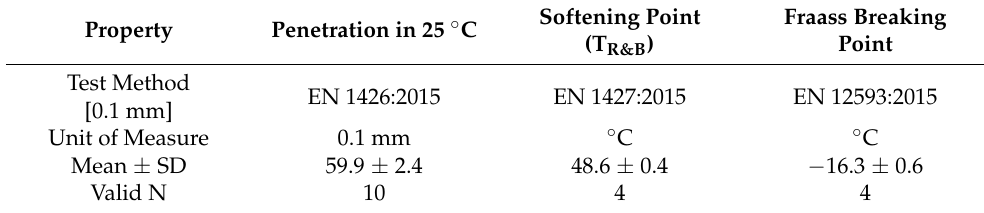
Figure 8. Bitumen foam maximum expansion ratio (ER) and half-life characteristics (HL) of the utilized 50/70 paving grade bitumen. Table 11. Properties of the 50/70 road